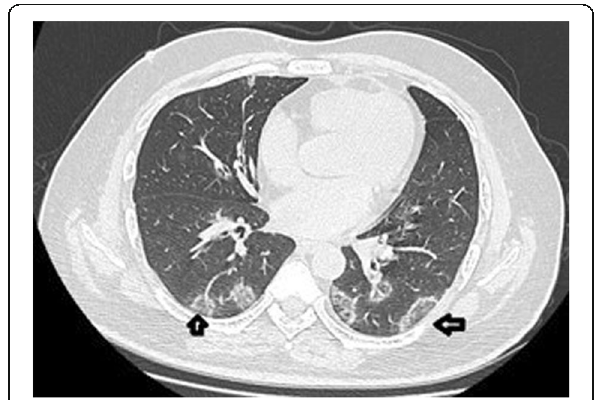
Fig. 5 Axial HRCT chest image of the patient (120 KV 100 mAs bone algorithm) at the level of heart showing bilateral multifocal ground glass lesions (open arrows) in both lower lobes in peripheral